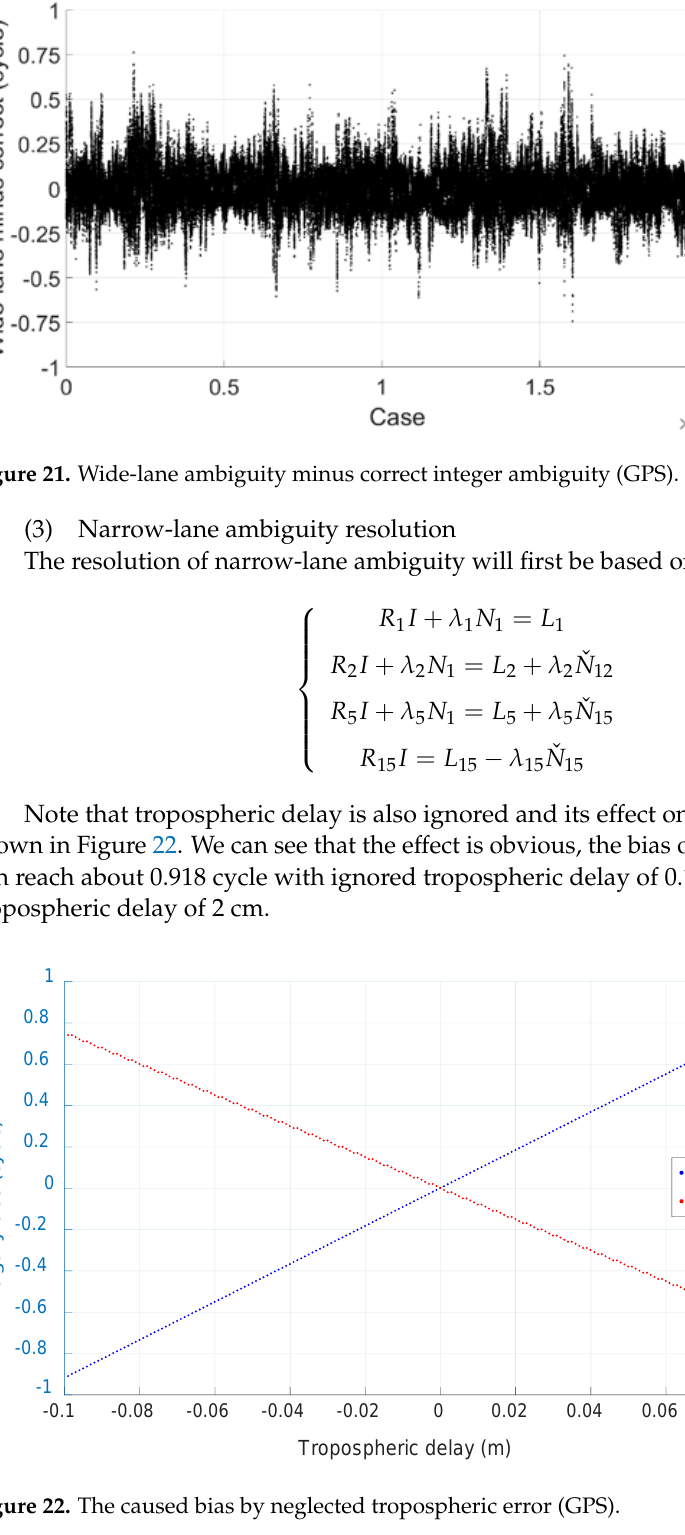
Figure 22. The caused bias by neglected tropospheric error (GPS). In order to reduce the effect of tropospheric error on narrow-lane ambiguity resolution, the difference is also formed between GPS satellites with closest tropospheric mapping functions. Figure 23 shows the statistics of the mapping function range after differencing and we can see that 42.9% are within 0.25 and more than 92% within 1.0, which means that with a zenith tropospheric error of 2 cm, about 40% of remaining tropospheric errors